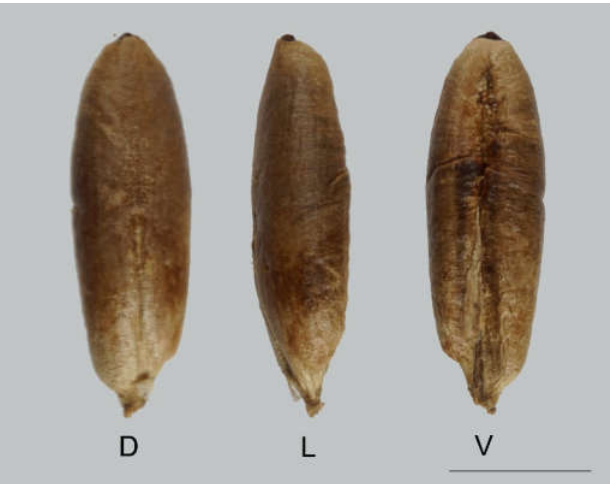
Figure 2. Seeds of Phoenix dactilifera L. in three views: dorsal ( D ), lateral ( L ), ventral ( V ). A groove is visible in the ventral side, opposed to the germination pore in a dorsal position. Bar equals 1 cm.